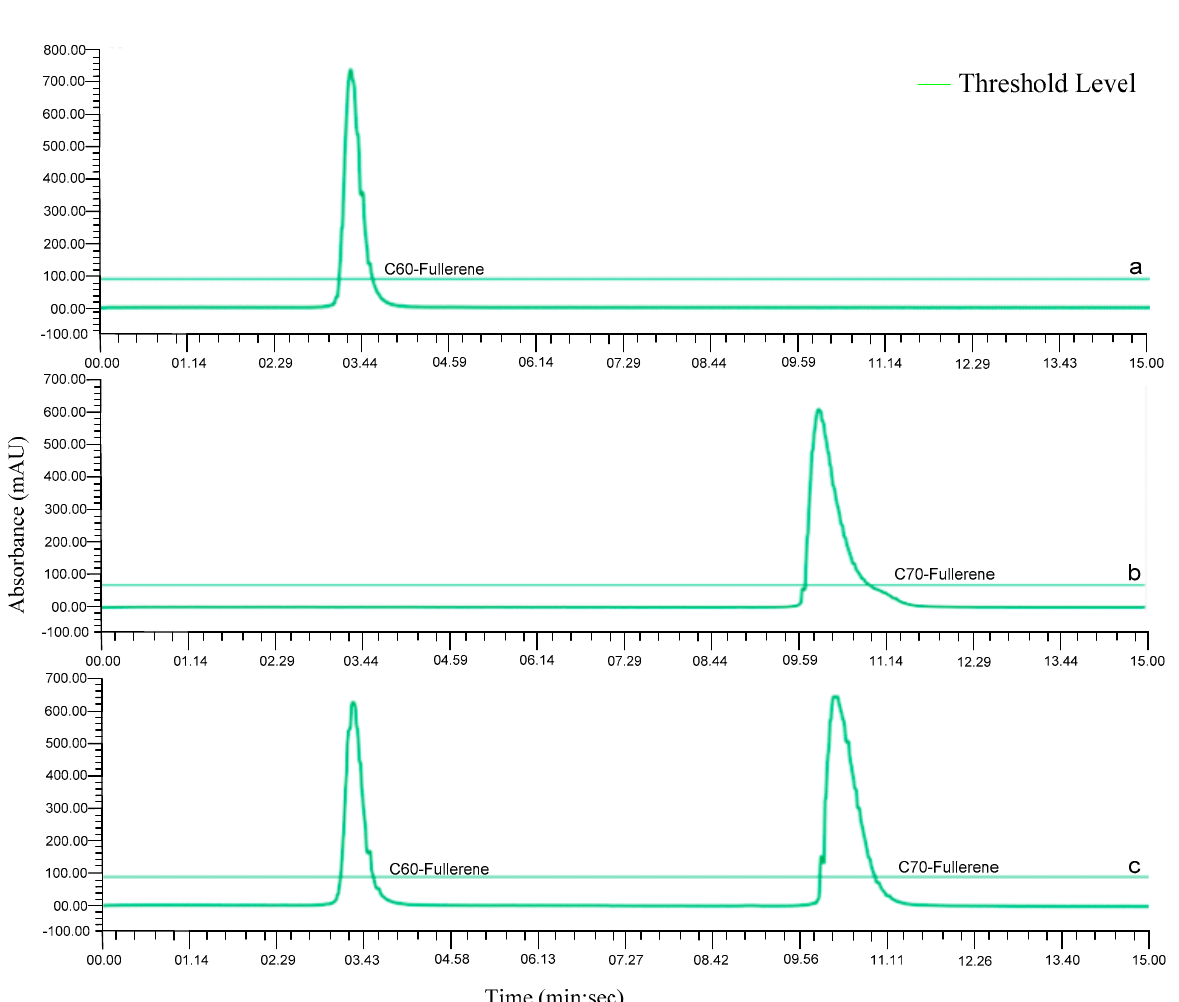
Figure 5. Chromatographic separation of fullerene standards: ( a ) C 60 -fullerene, ( b ) C 70 -fullerene and ( c ) an equimolar mixture of C 60 and C 70 -fullerenes ( c ) on silica-bound C -butylpyrogallol[4]arene stationary phases 3b . Concentration: 25 mg mL − 1 detection wavelength: 200-400 nm, mobile phase: ethyl acetate:toluene (35:65), flow rate: 15 mL min − 1 , elution: isocratic, run time: 15 min, column dimensions: 62 × 412 mm i.d.